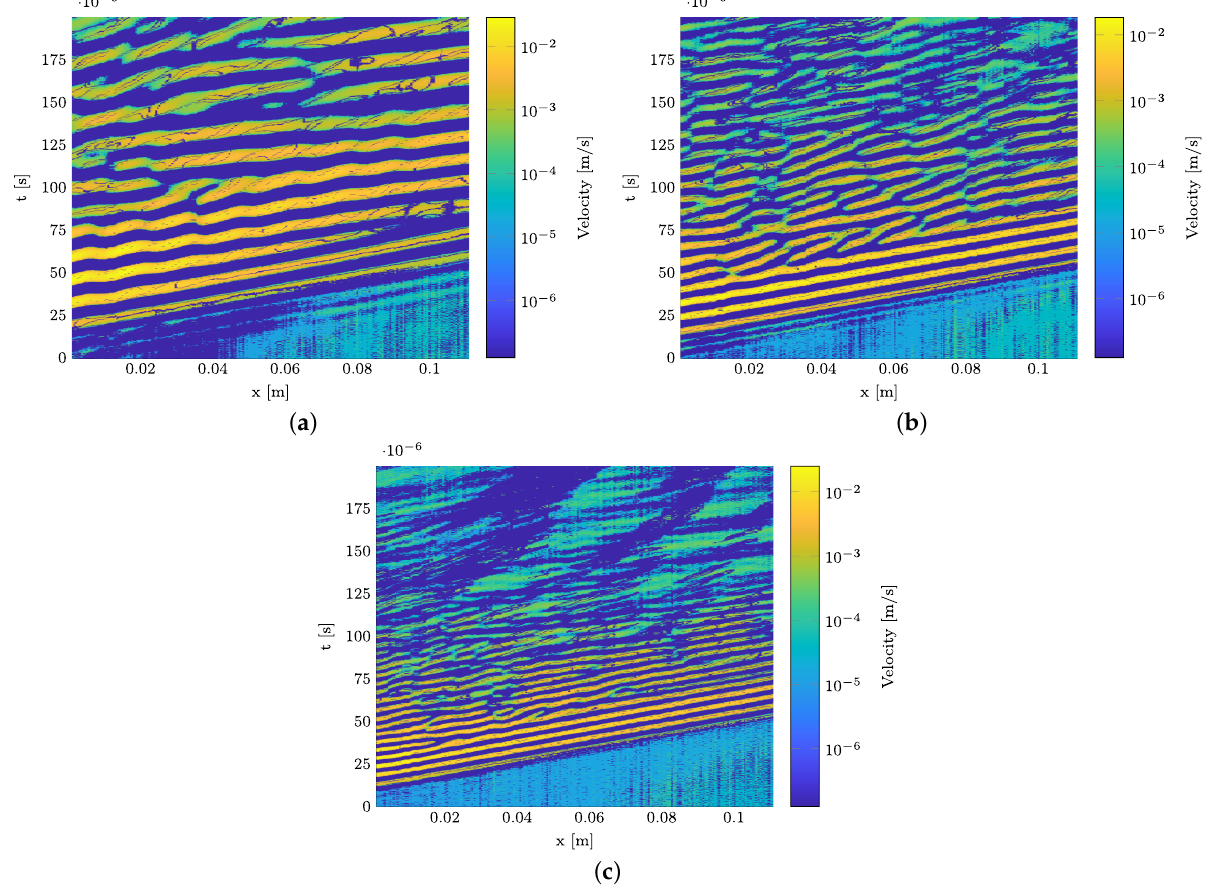
Figure 11. Experimentally determined B-scan of the GFRP strip specimen along the measurement path from actuator to polyimide inlay. The polyimide inlay starts at 0.09m, cf. Figure 3. In-plane